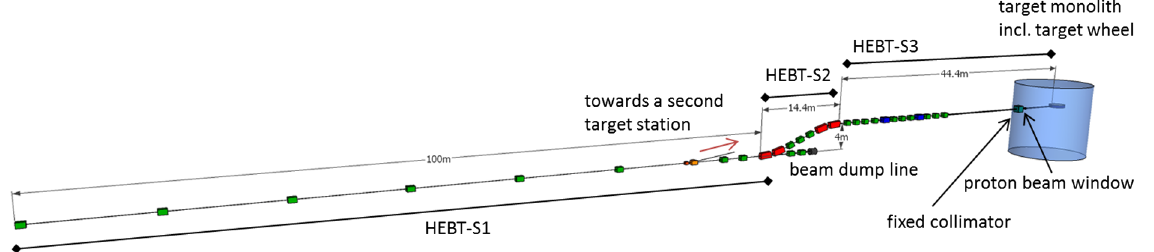
window.FIG. 1. The layout of a short section of the HEBT-S1, the HEBT-S2 and HEBT-S3. The layout includes the magnets — quadrupoles (green), dipoles (red), and octupoles (blue), the fixed collimator (cyan), and the target monolith (including the proton beam window and the target wheel) to shield the neutrons from the